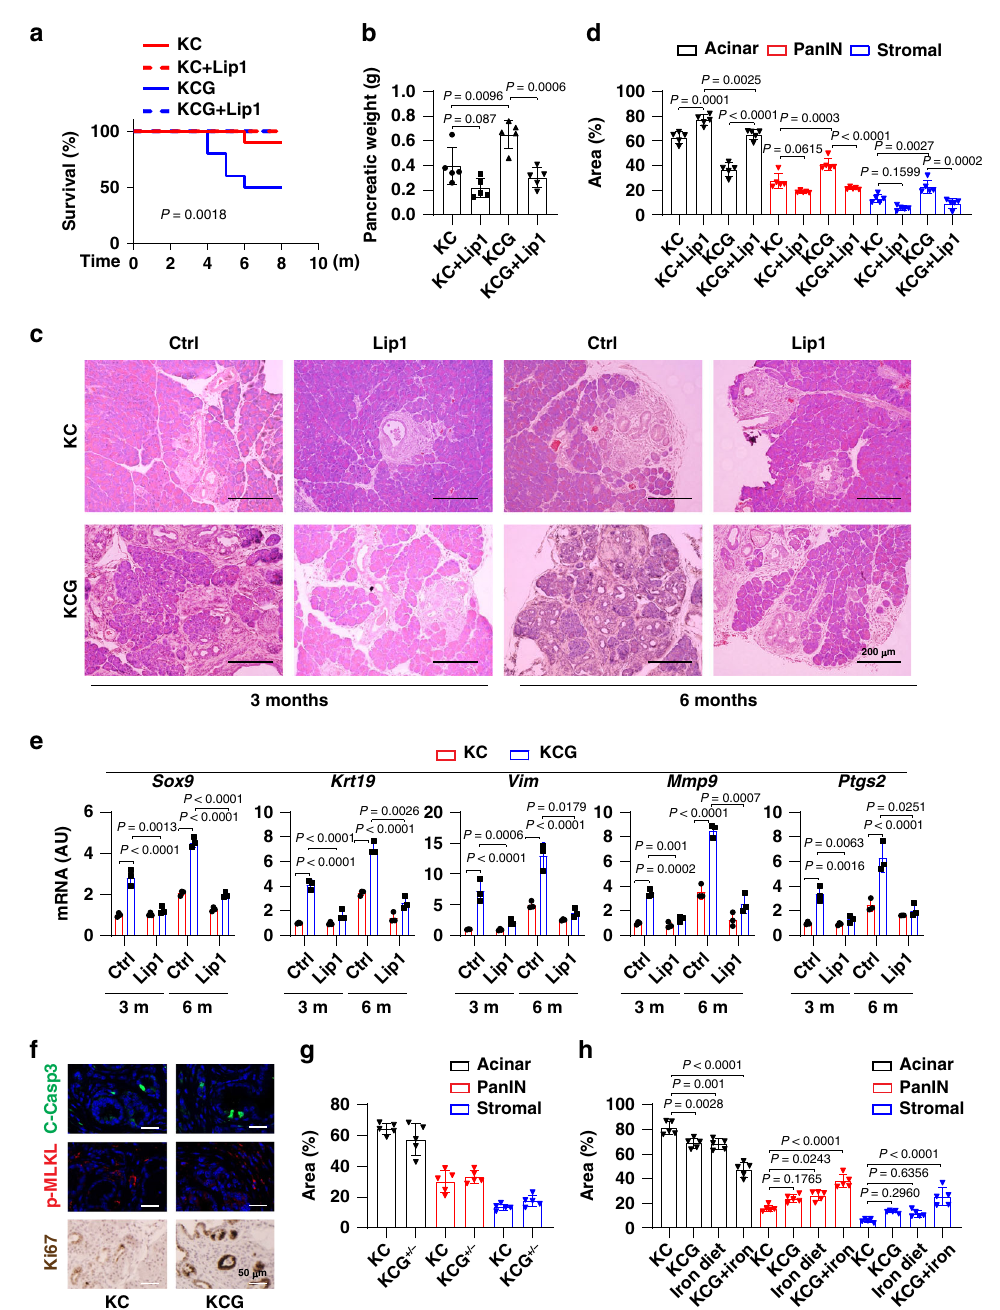
Fig. 2 Gpx4 depletion promotes Kras -driven pancreatic tumorigenesis. a Survival of Pdx1-Cre;K-Ras G12D/ + (KC) and Pdx1-Cre;K-Ras G12D/ + ;Gpx4 − / − (KCG) mice with or without liproxstatin-1 (Lip1) treatment ( n = 10 mice/group; one-sided log-rank [Mantel – Cox] test). b Pancreatic weight of the indicated KC and KCG mice (6 months; n = 5 mice/group; two-way ANOVA with Tukey ’ s multiple comparisons test). c Representative pancreas histology of the indicated KC and KCG mice. d Percentages of histological structures in the pancreas of the indicated KC and KCG mice (6 months; n = 5 mice/group; two- way ANOVA with Tukey ’ s multiple comparisons test). e , f Relative gene or protein expression in the pancreas of the indicated KC and KCG mice ( n = 3 mice/group; two-way ANOVA with Tukey ’ s multiple comparisons test). g Percentages of histological structures in the pancreas of the indicated KC and KCG + / − mice (6 months; n = 5 mice/group; two-way ANOVA with Tukey ’ s multiple comparisons test). h Percentages of histological structures in the pancreas of the indicated KCG mice with or without high-iron diets (3 months; n = 5 mice/group; two-way ANOVA with Tukey ’ s multiple comparisons test). Data in b , d , e , g , and h ) are presented as mean ± SD. Data are from two or three independent